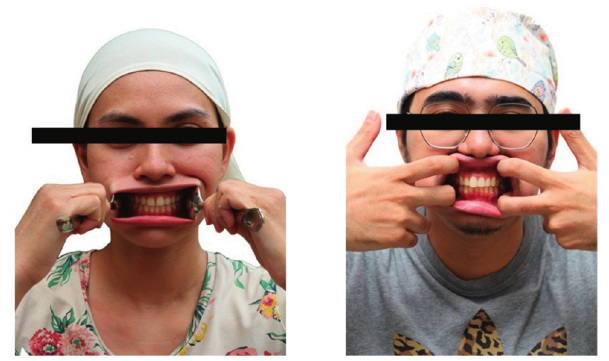
Figure 7: Retraction of the cheek using a spoon and